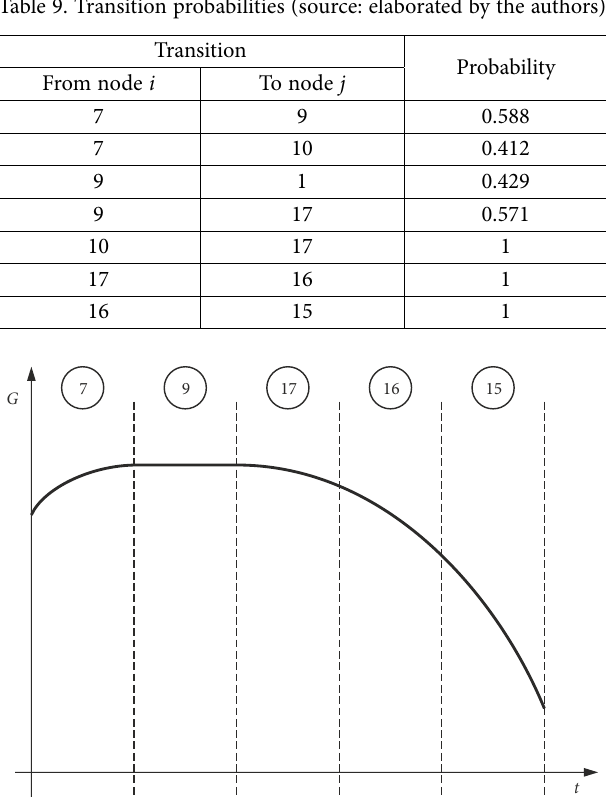
Figure 7. Qualitative description of function G (t) (source: elaborated by the